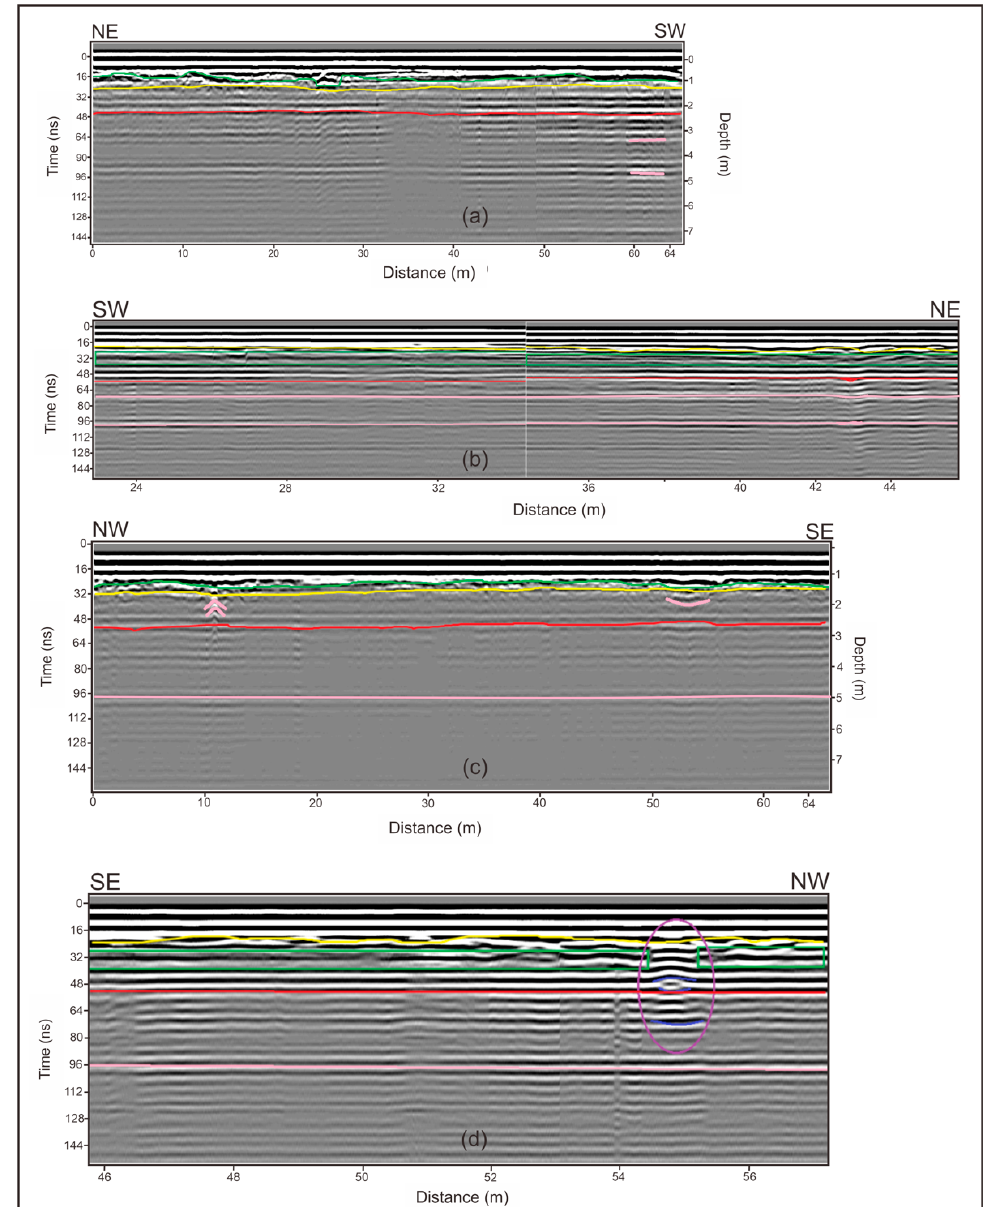
Figure 6. GPR profiles at site 2, Persiaran Bayan Indah (in front of the Queensbay Mall), representing anthropogenic coastal landform. ( a ) Line 5-Anomalies on the surface as shown as undulating green line interpreted as the upper reclamation subsurface; ( b ) Line 6–at a depth of 1.5 m, the undulating reflectors corresponds to top filling sediment, and there are tiny reflections that penetrate through as the unsaturated reclamation area. Another reflector at a depth of 2 m (red line) is interpreted as the water table; ( c ) Line 7–corresponds to lines 5 and 6, the green undulated line found at a depth of 1.5 m interpreted as top of aggregates filling. At the distance of 11 m, 16 m, and 53 m, suggests more resonant penetrated signals due to the man-made structure, could be coming from pipework from the Queensbay mall to the sea; ( d ) Line 8–noise (purple circle) at the distance of 54 m, where the signal penetrated more in-depth into the profile due to the electrical motion from the underground wiring that connected to an existing utility pole on the